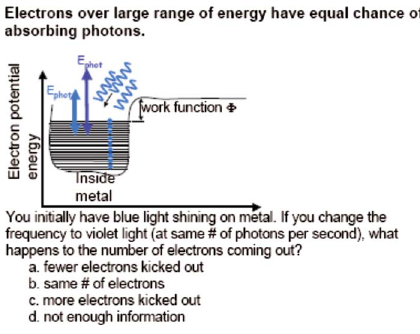
FIG. 6. (cid:1) Color (cid:2) Screen shot of a conceptual CQ in Red’s class- room (cid:1) correct answer: C